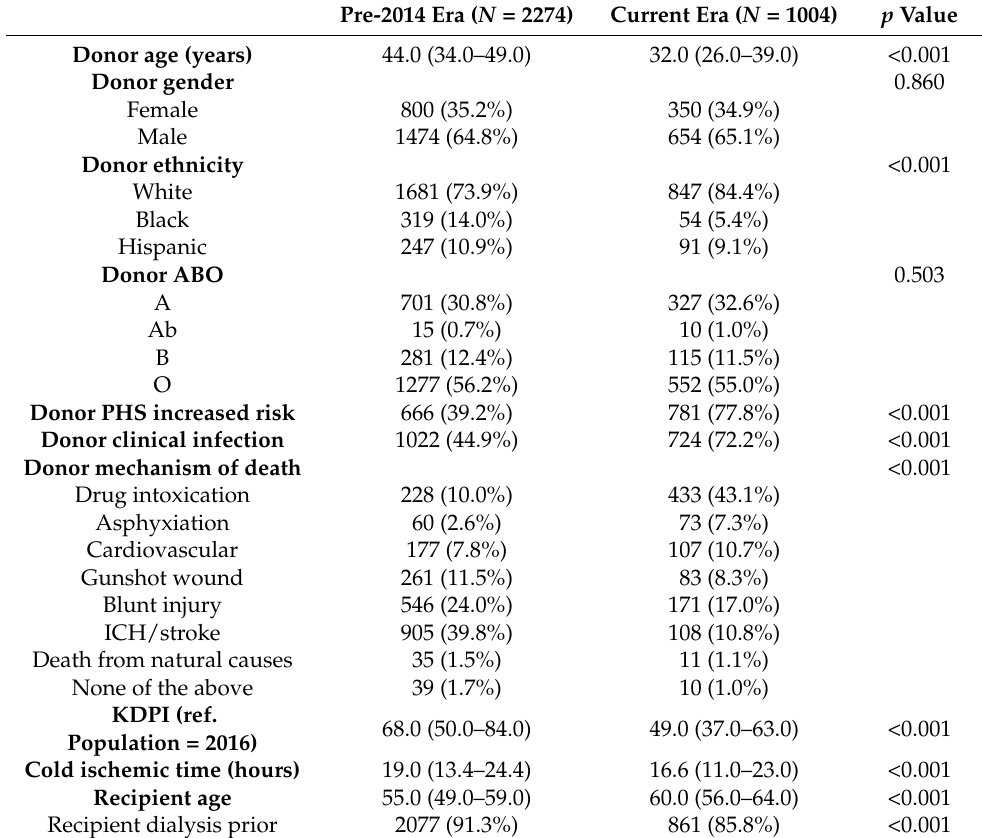
Table 3. Kidney demographics and clinical characteristics from HCV seropositive donors by era.